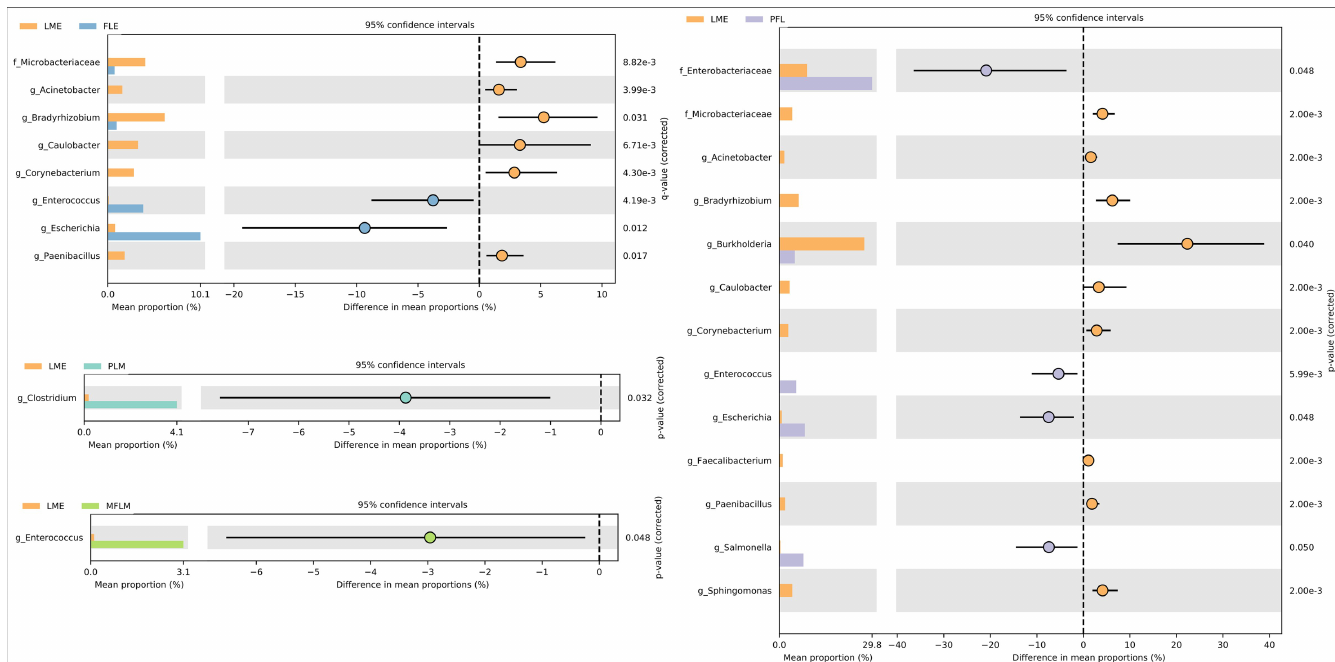
Fig 3. Differential microbial abundance among microbial communities detected in samples from preterm babies fed with different diets during 28 days. p-values were obtained by the two-sided White’s non-parametric t-test followed by the Benjamini-Hochberg FDR correction. A p-value of < 0.05 together with effect size filter (difference between proportions effect size < 1.00) was applied to determine the most important taxa that differed between treatments. Only statistically significant differences are shown.